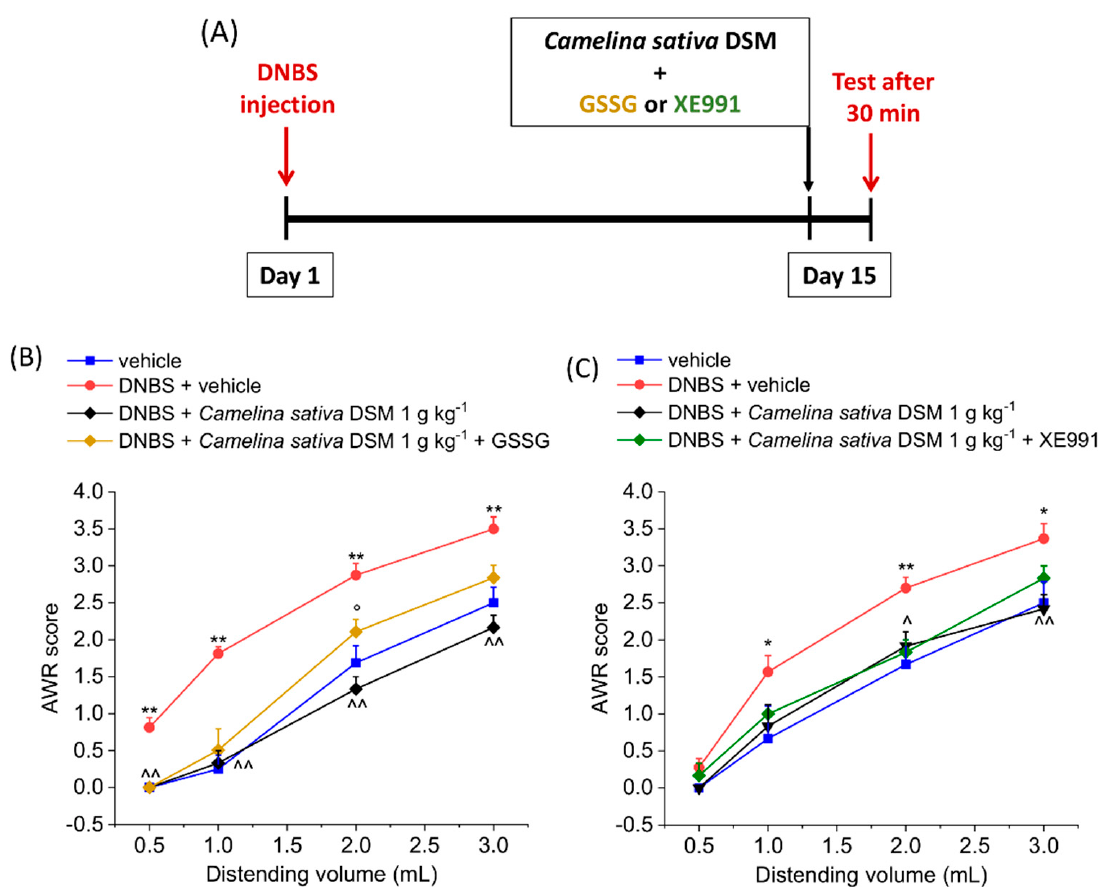
Figure 2. The involvement of H 2 S and Kv7 potassium channels in the acute pain-relieving effects of Camelina sativa DSM. ( A ) Experimental scheme: the behavioural test was performed 30 min after the oral administration of the Camelina sativa DSM (0.1–1 g kg − 1 p.o.). Visceral sensitivity was assessed in animals by measuring the extent of the abdominal withdrawal response (AWR) to colorectal dis- tension, carried out by applying an increasing distending stimulus on the colon walls (0.5–3 mL). ( B ) Oxidized glutathione (GSSG) (20 mg kg − 1 ) was orally administered in concomitance with Came- lina sativa DSM (1 g kg − 1 ), and the test was performed after 30 min. ( C ) The Kv7 potassium channel blocker XE991 (1 mg kg − 1 ) was intraperitoneally administered in concomitance with Camelina sativa DSM (1 g kg − 1 ), and the test was performed after 30 min. Each value represents the mean ± SEM of six animals per group. * p < 0.05 and ** p < 0.01 vs. vehicle. ^ p < 0.05 and ^^ p < 0.01 vs. DNBS +